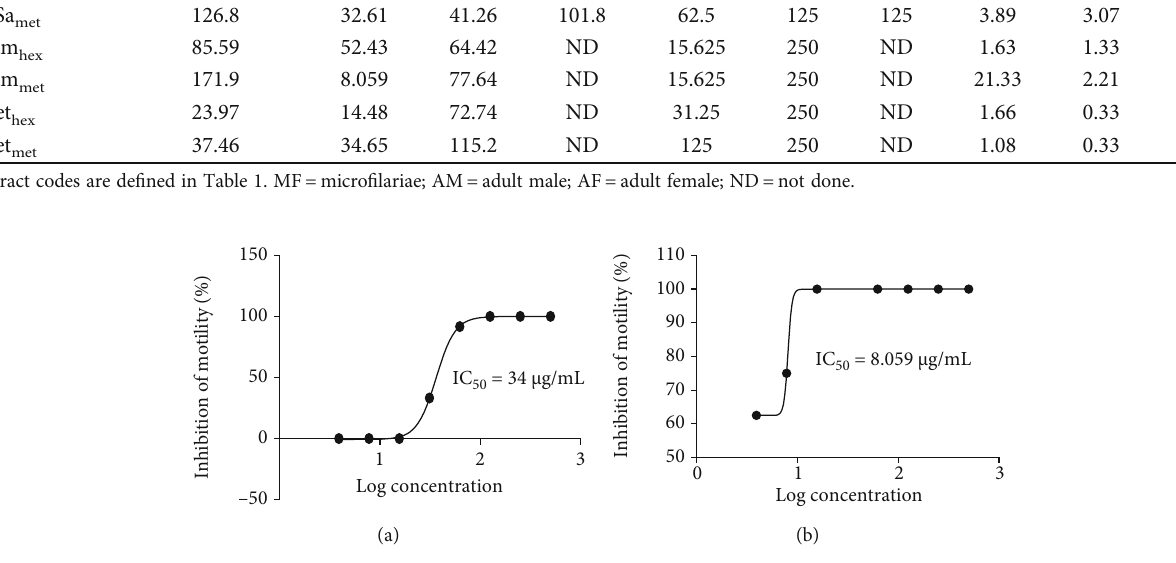
Figure 1: Dose-dependent activity of lichen extracts against Onchocerca ochengi adult worms. (a) Hexane extract of U. articulata against female worms. (b) Methanol extract of P. tinctorum against male worms.